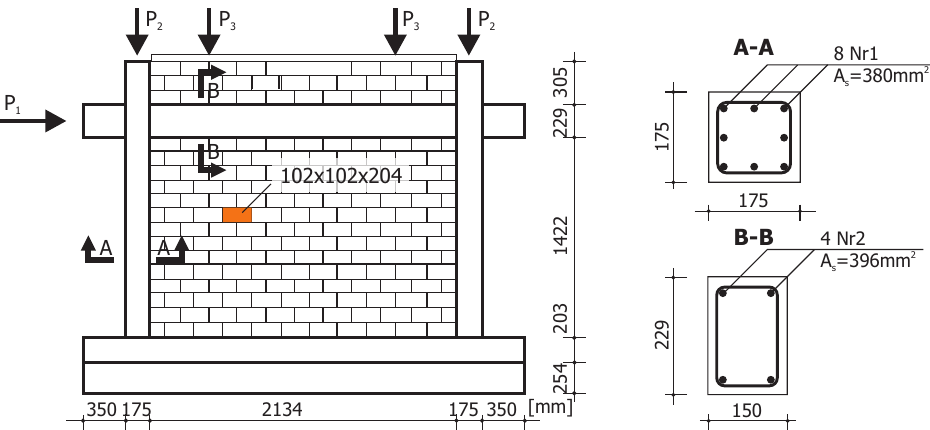
Figure 18. Geometry and loads for masonry infill wall tested in [45].